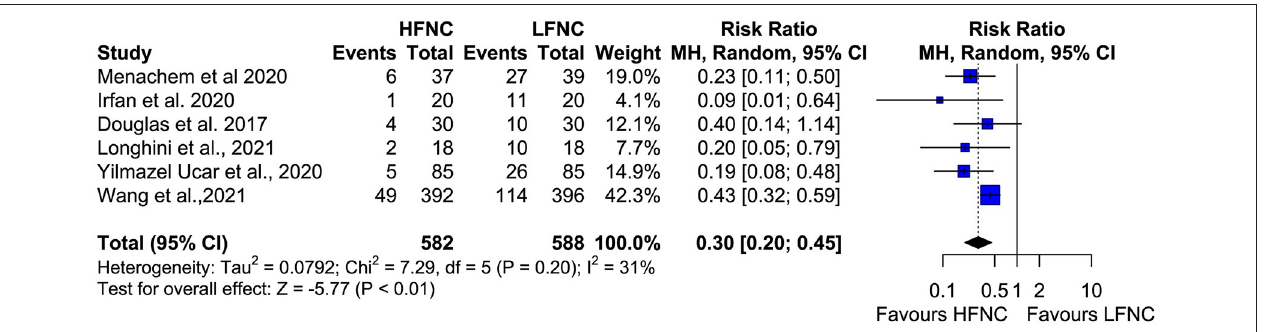
FIGURE 4 | Meta-analysis of desaturation events (SpO2 < 90%) in patients receiving HFNC compared to LFNC in patients undergoing bronchoscopic